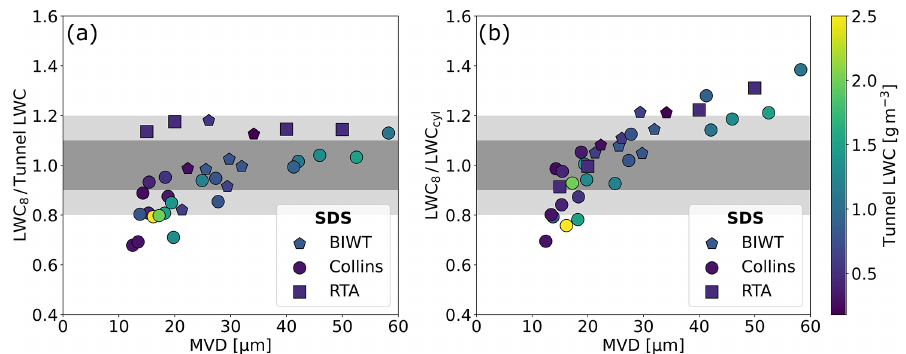
Figure A2. Comparison of the collision-efficiency corrected 8mm cone measurements to the tunnel LWC (a) and to the collision-efficiency corrected LWC sensor measurements (b) .